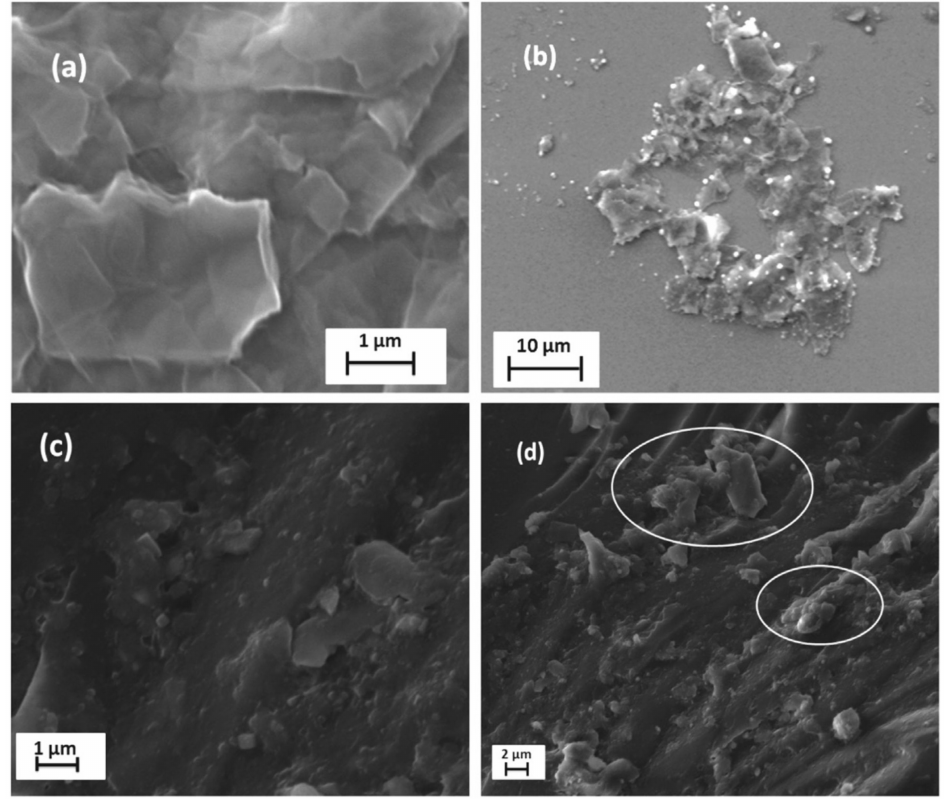
Figure 7. SEM images: ( a ) GO flakes; ( b ) dispersed GO flakes; ( c ) GO flakes dispersed in epoxy; ( d ) agglomeration of GO flakes in resin [67]. Obtained with permission from Composites Science and Technology; published by Elsevier,